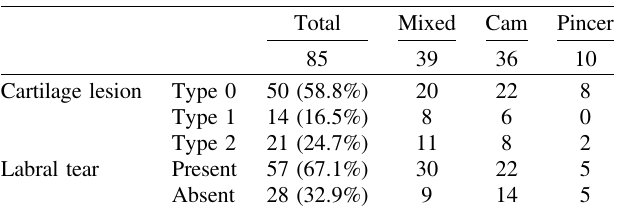
Table 1. Number of hips in each FAI type and in each subgroup according to chondral and labral